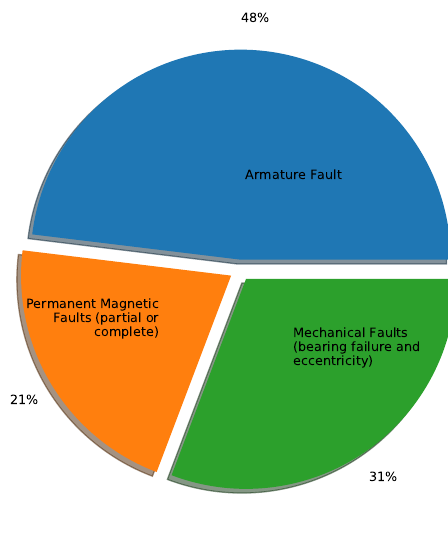
Figure 6. Distribution of the papers according the type of